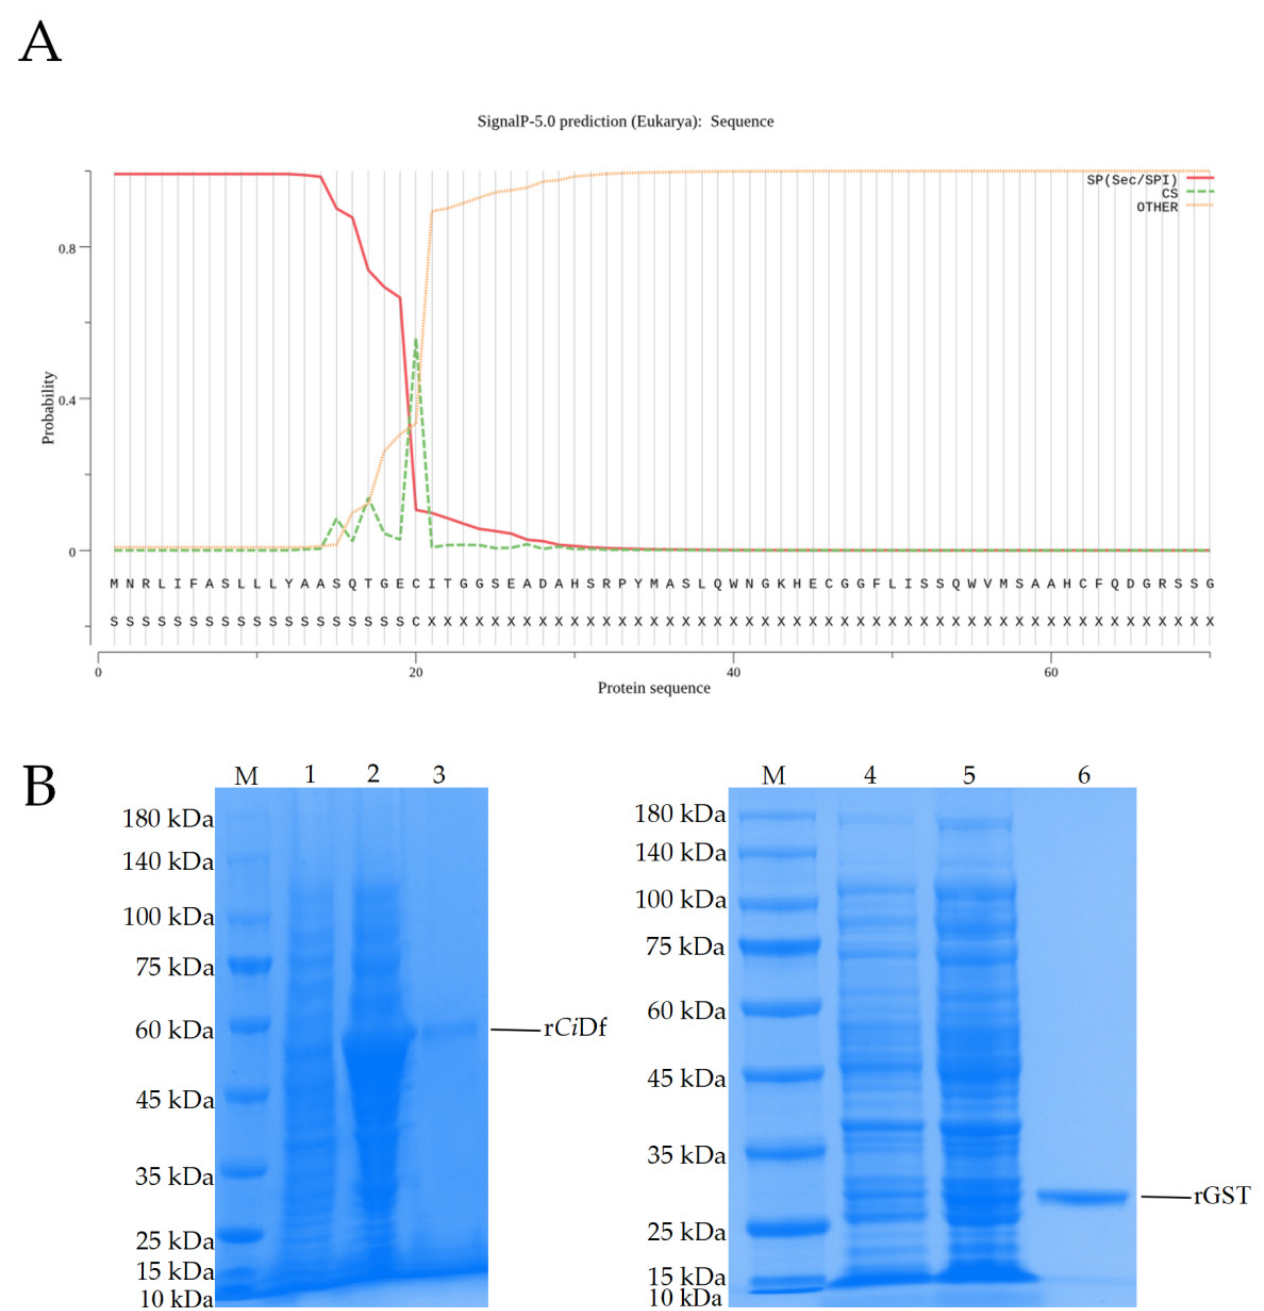
Figure 7. Signal peptide prediction for the Ci Df protein and SDS-PAGE analysis of the recombinant Ci Df protein. ( A ) The first 20 amino acid residues were predicted to form a signal peptide in the Ci Df protein using the SignalP-5.0 tool. ( B ) SDS-PAGE analysis of recombinant Ci Df protein. M: marker; Lane 1: lysates of pGEX-4T-1- Ci Df plasmid transformed bacteria before induction; Lane 2: lysates of pGEX-4T-1- Ci Df plasmid transformed bacteria after induction with 1 mM IPTG; Lane 3: purified r Ci Df protein; Lane 4: lysates of pGEX-4T-1 plasmid transformed bacteria before induction; Lane 5: lysates of pGEX-4T-1 plasmid transformed bacteria after induction with 1 mM IPTG; Lane 6: purified rGST protein.